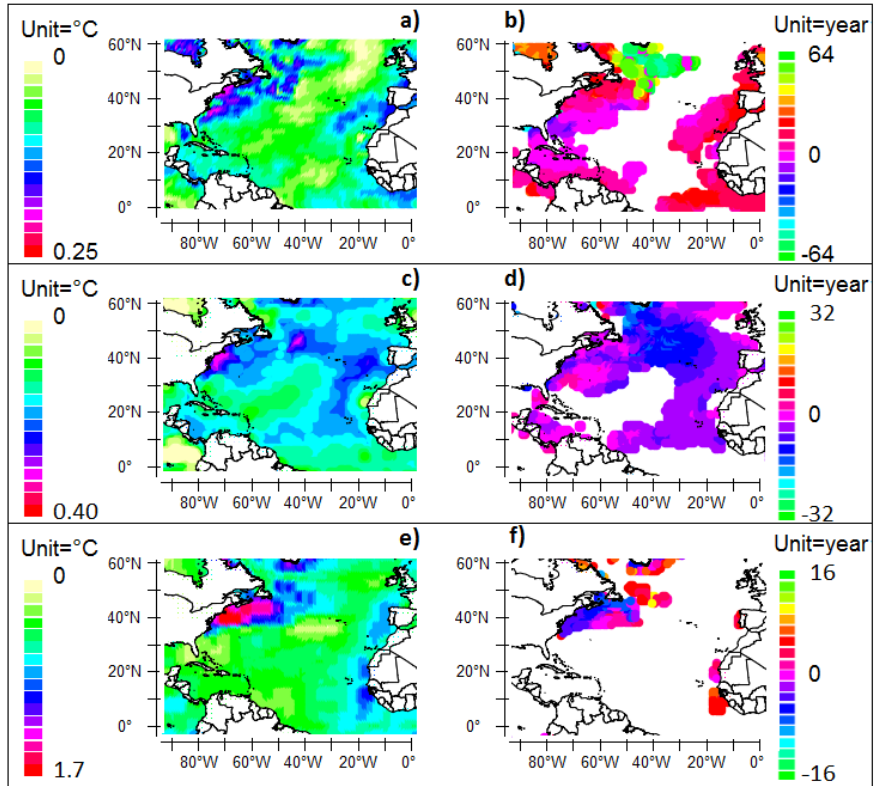
Figure 2. Amplitude ( a ) and phase ( b ) of the cross-wavelet of SST, scale-averaged over the band 96 – 144 years (128 year average period). Time lags are represented in years compared to the sunspot number whose maximum is reached in 1969. Since the period of the Gyral Rossby Wave (GRW) is close to the observation period, the amplitude and phase of anomalies are validated by comparison with that obtained by filtering (Figure 3). Amplitude ( c ) and phase ( d ) of the cross-wavelet of SST, scale-averaged over the band 48–96 years (64 year average period). The maximum sunspot number is reached in 1958 within this band. Amplitude ( e ) and phase ( f ) of the cross-wavelet of SST, scale-averaged over the band 24–48 years (32 year average period). The maximum sunspot number is reached in 1989 within this band. Data are provided by the “Met Office Hadley Centre” http://hadobs.metoffice.com/hadisst/data/download.html [19].